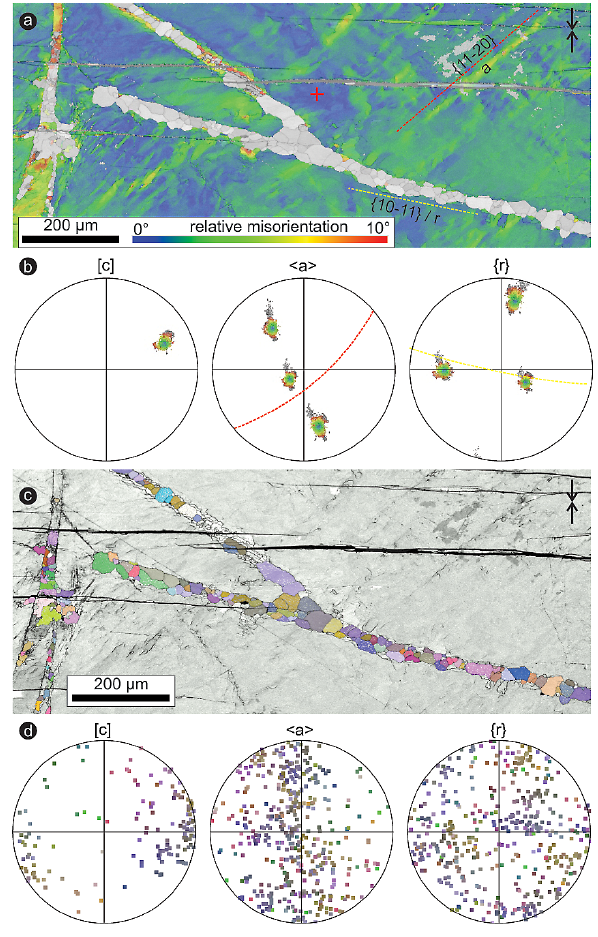
Fig. 7. SWUE and recrystallized quartz (grain size 17 ± 9µm) from “kick and creep” experiment CR1-17 initially deformed at 400 ◦ C, 2GPa confining pressure, 10 − 4 s − 1 strain rate, and afterwards at 900 ◦ C, 2.5GPa confining pressure and approximately constant stress. The shortening direction is indicated by black arrows. (a, b) EBSD map showing misorientation relative to reference point marked by red cross and corresponding pole figures. Orientation of { a } prism and { r } rhombohedral planes are displayed as traces in (a) and as great circles in (b) . (c, d) EBSD map showing new grains, colour coding according to Euler angles corresponds to pole fig- ures; crystallographic orientation of new grains is nearly random; orientation control by host grain is